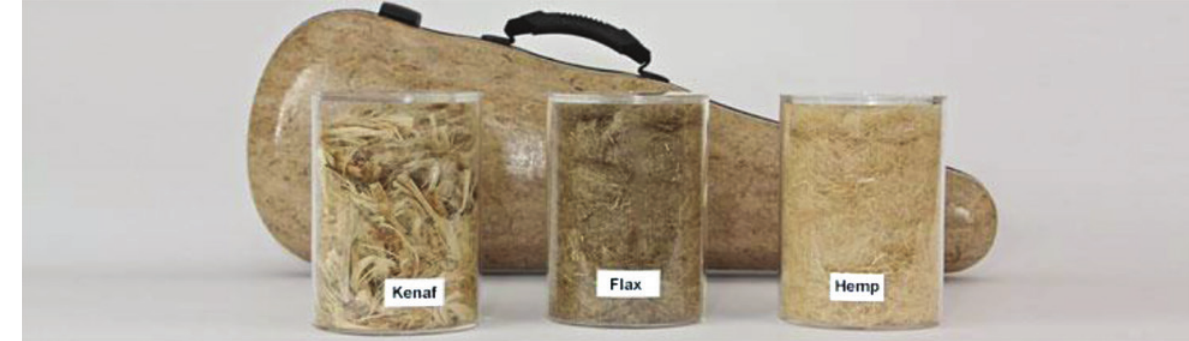
Figure 6: Cases for musical instruments made of quickly renewable, biobased natural fiber composites